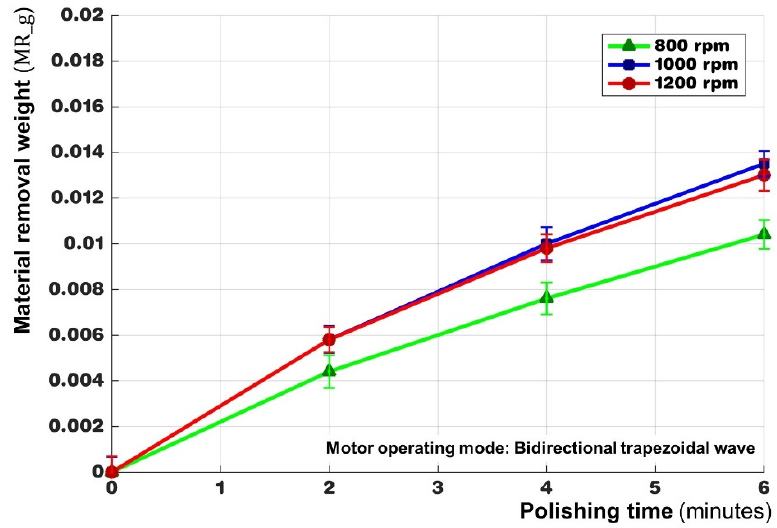
Figure 10. Comparison chart of average material removal weight and polishing time of three kinds of silicon carbide particle